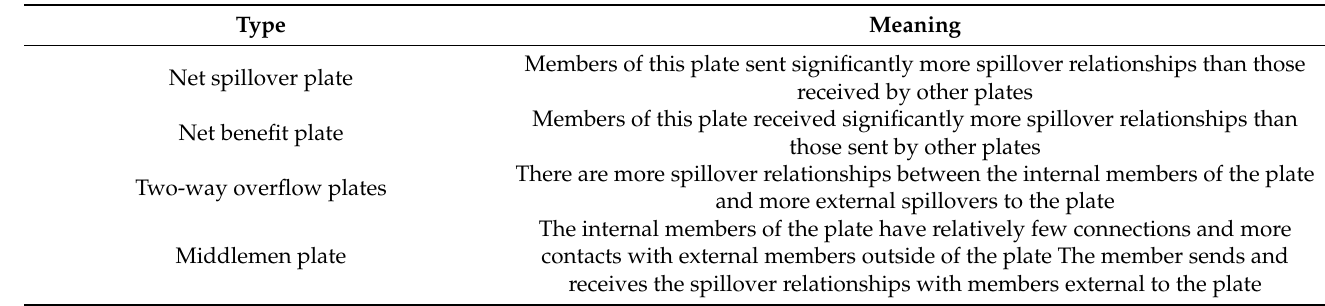
Table 5. The four major plates in China’s agricultural science and technology resource allocation efficiency